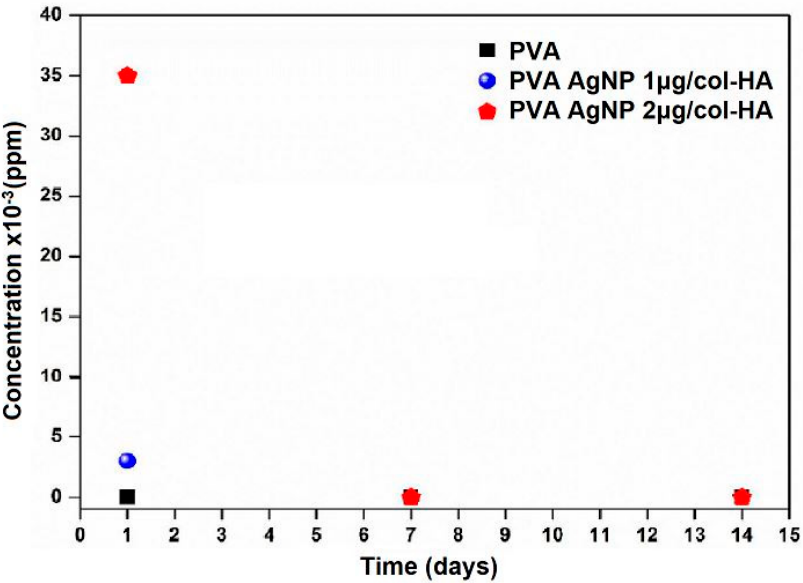
Figure 4. The AgNP release from PVA after 1, 7, and 14 days in DMEM culture medium detected by ICP-OES. This experiment was performed in duplicate.